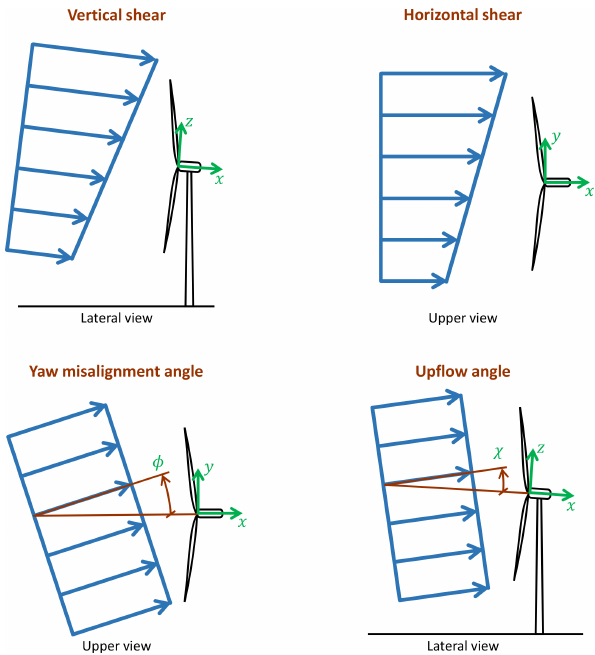
Figure 1. Definition of the four wind states used for parameterizing the wind field over the rotor disk. shown in Fig. 1: unit vector x is aligned with the rotor axis and faces downwind, z points upward in the vertical plane, while y is defined according to the right-hand rule. The com- ponents of the wind vector in the nacelle-attached frame of reference are noted V = { u,v,w } T and they